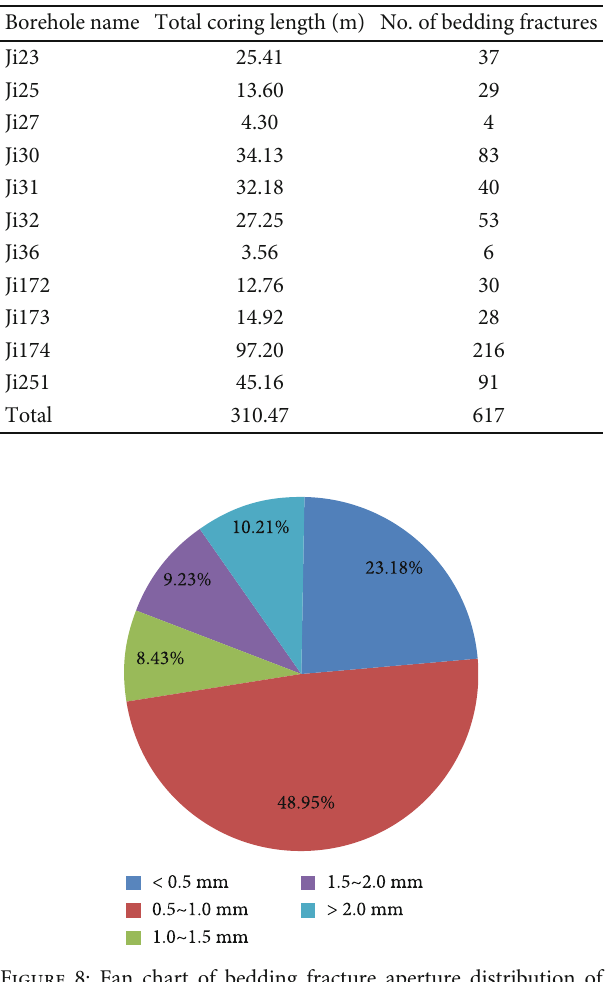
Table 3: Statistical table of number of bedding fractures observed in cores from Lucaogou formation in Jimsar sag.